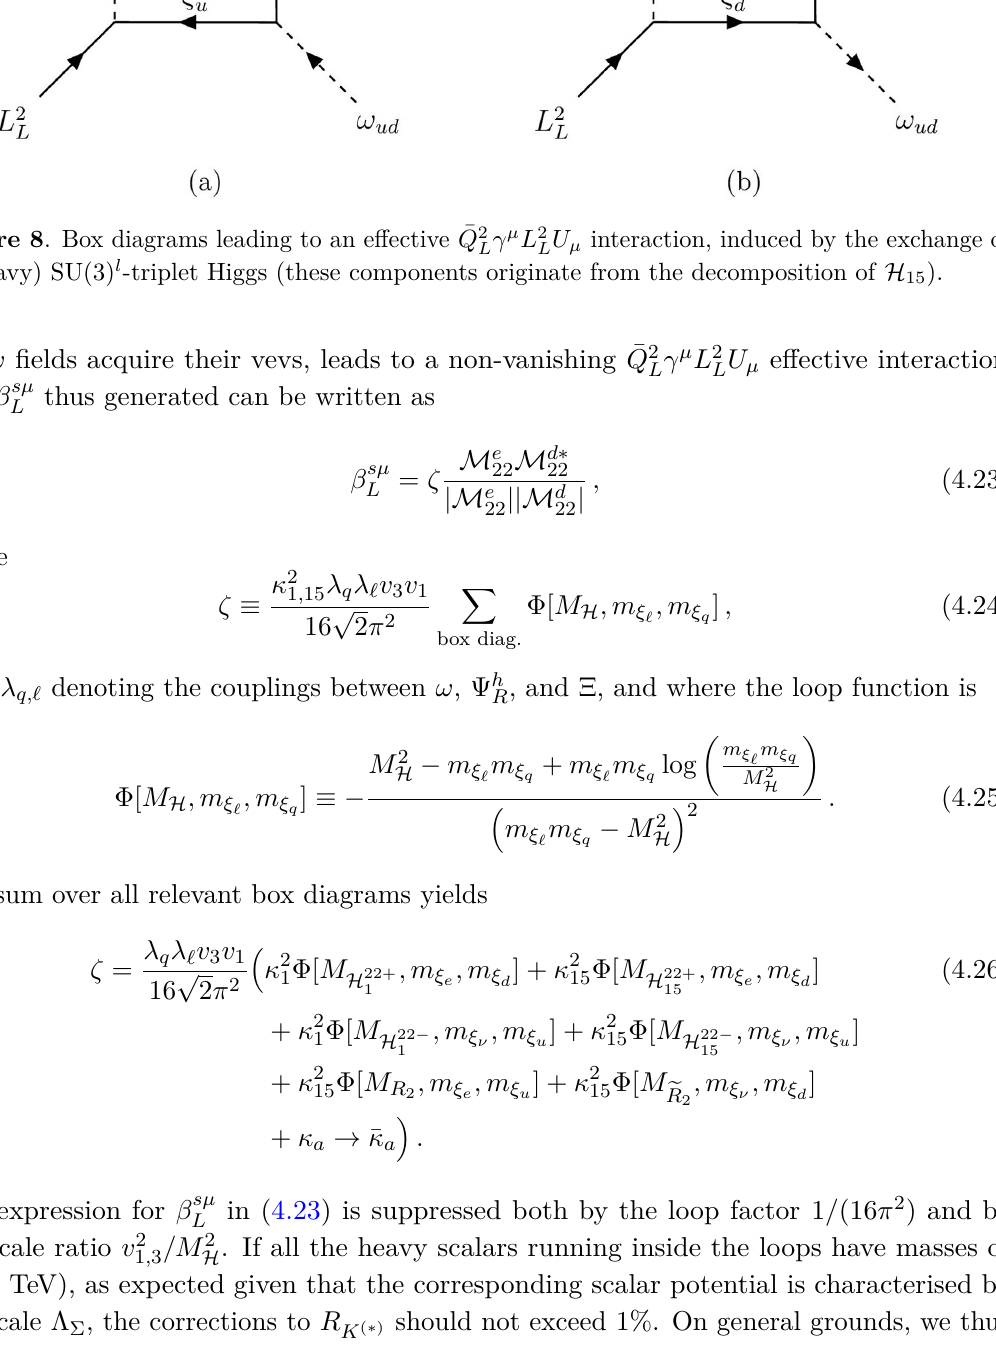
¯ Q 2 γ µ L 2 U µ interaction, induced by the exchange of L L